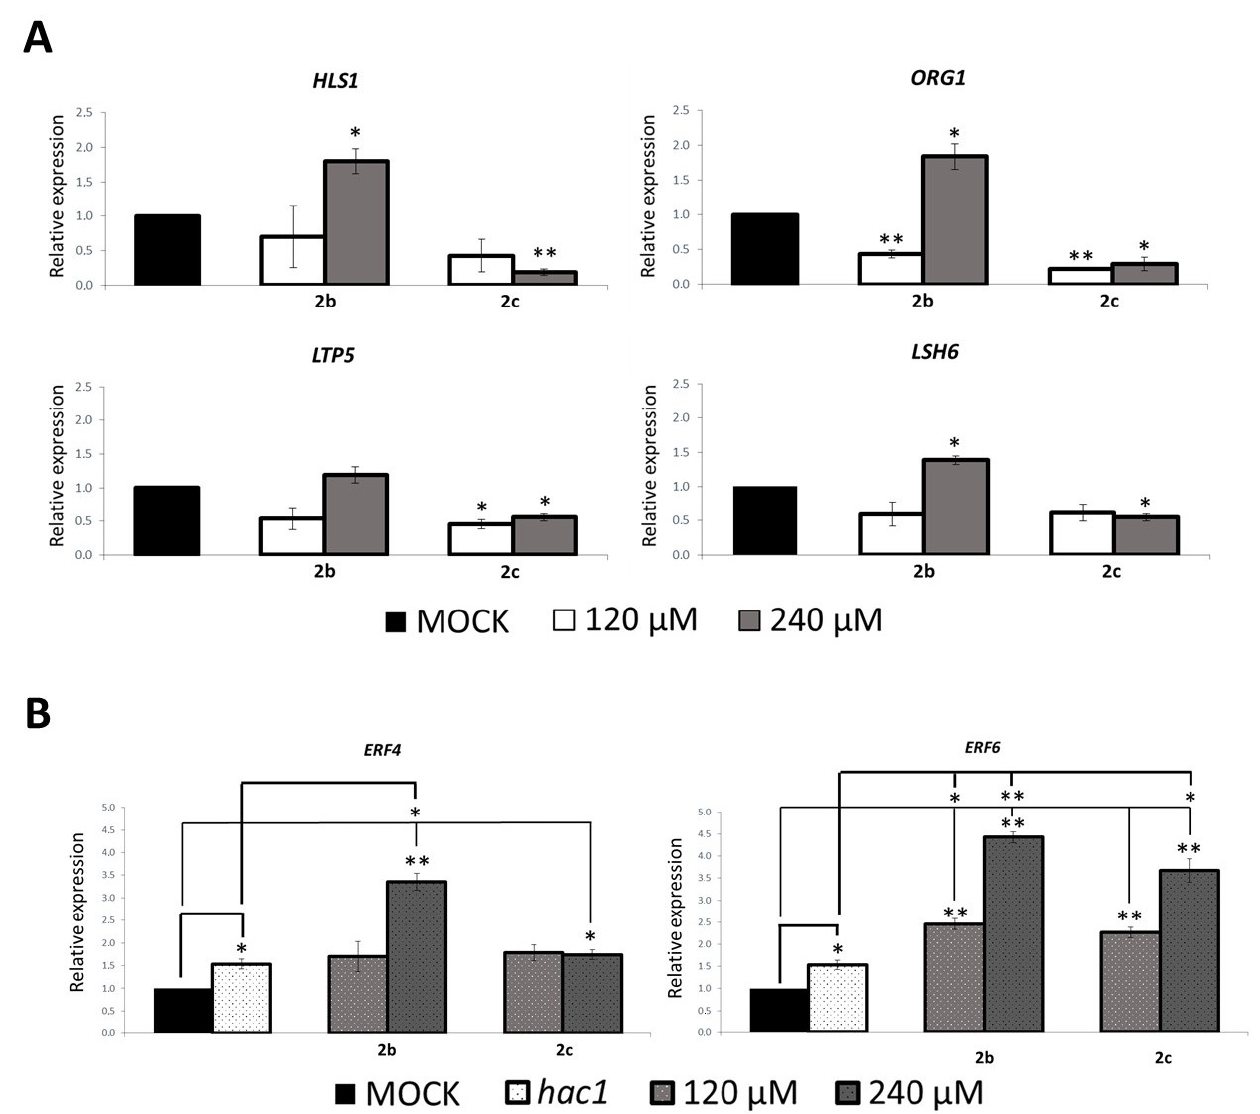
Figure 6. Treatment with 2b and 2c affects expression of target genes. Relative expression level of: ( A ) HLS1 , ORG1 , LTP5 and LSH6 in 2b - and 2c -treated 6-day-old dark-grown wild type seedlings, ( B ) ERF4 ( left ) and ERF6 ( right ) in 2b - and 2c -treated 6-day-old dark-grown hac1 seedlings. Treated samples were compared to DMSO-treated wild type seedlings (MOCK), which was set to 1. RT-qPCR assays were performed with 1 μ L of the diluted cDNA, along with the specific primers, listed in Table S1. Relative expression levels were normalized with the GAPA1 (AT3G26650) and UBQ10 (AT4G05320) reference genes. The values of relative expression level are means of three biological replicates, presented with SD values. Significant differences were analyzed by t -test (* p ≤ 0.01; ** p ≤ 0.005).